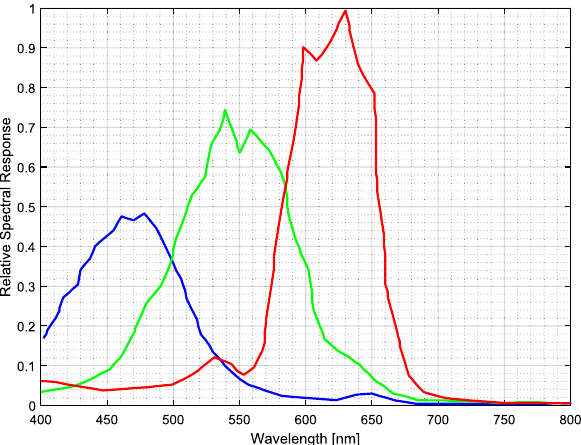
Figure 2. Relative spectral response versus wavelength of Photron SA-Z color